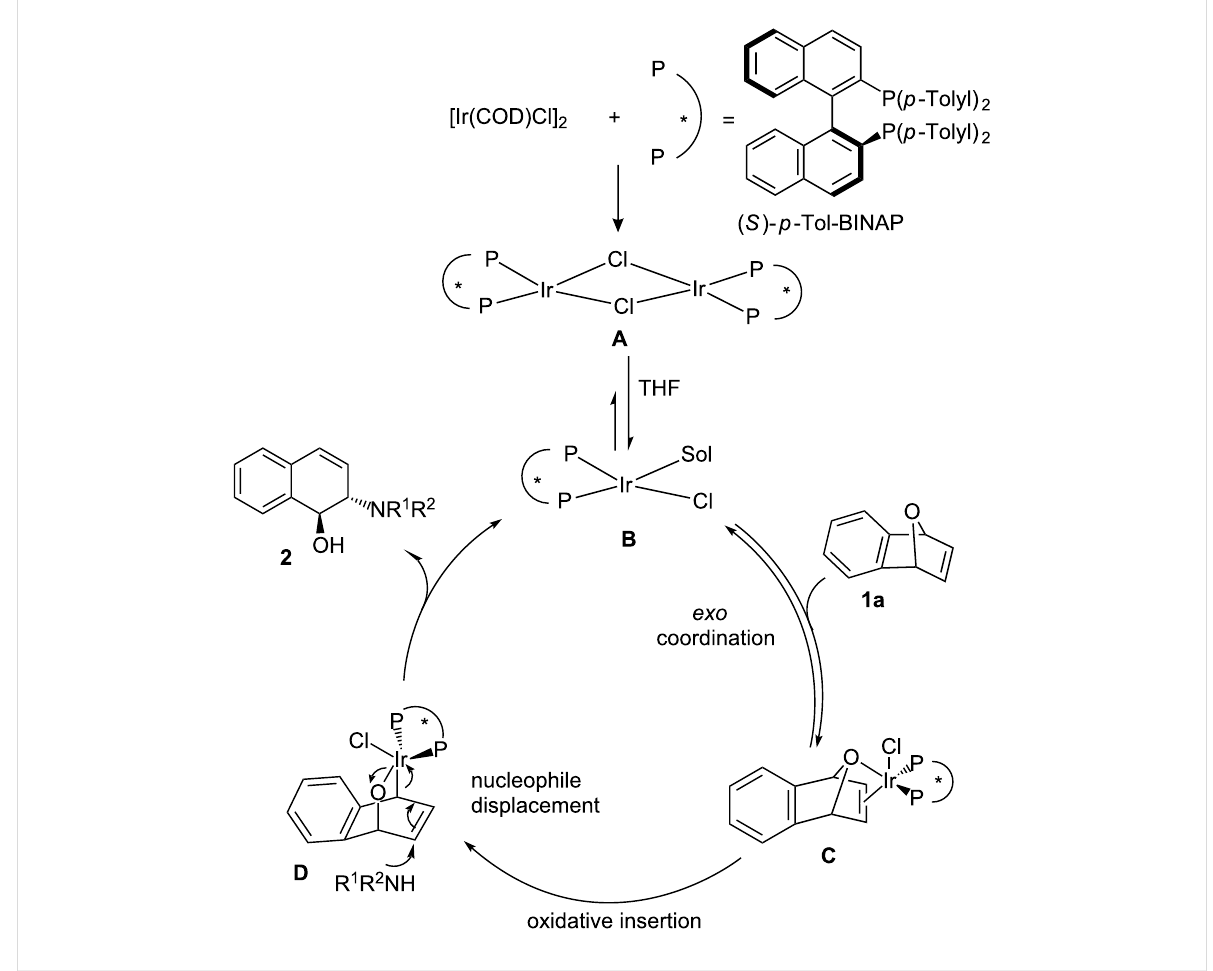
Scheme 2: Proposed mechanism for the ARO of oxabenzonorbornadiene 1a with secondary amine nucleophiles.